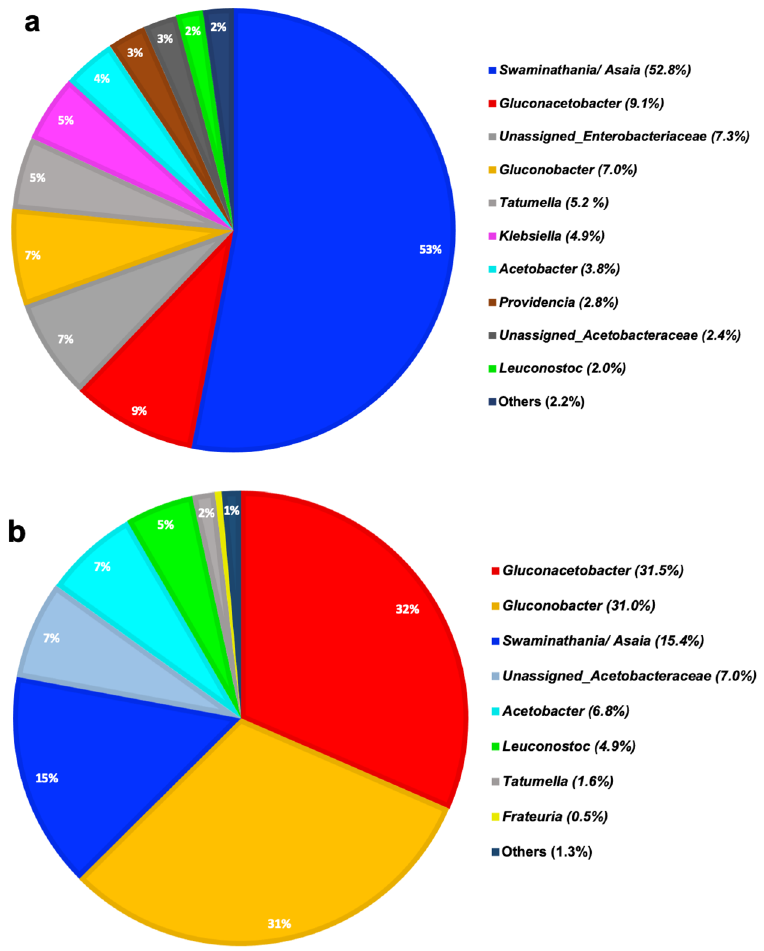
Figure 2. Percentage of mean relative abundance of the bacteria at the genus levels in ( a ) the B. tryoni wild larval samples and ( b ) fruit